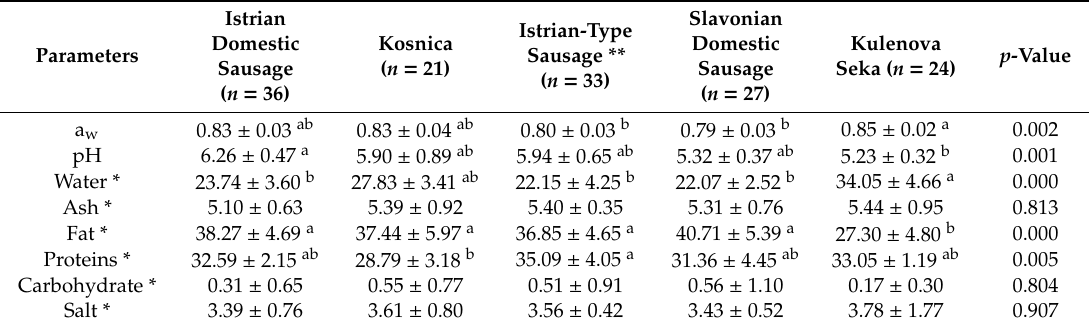
Table 4. Chemical and physical properties of Croatian traditional dry-fermented